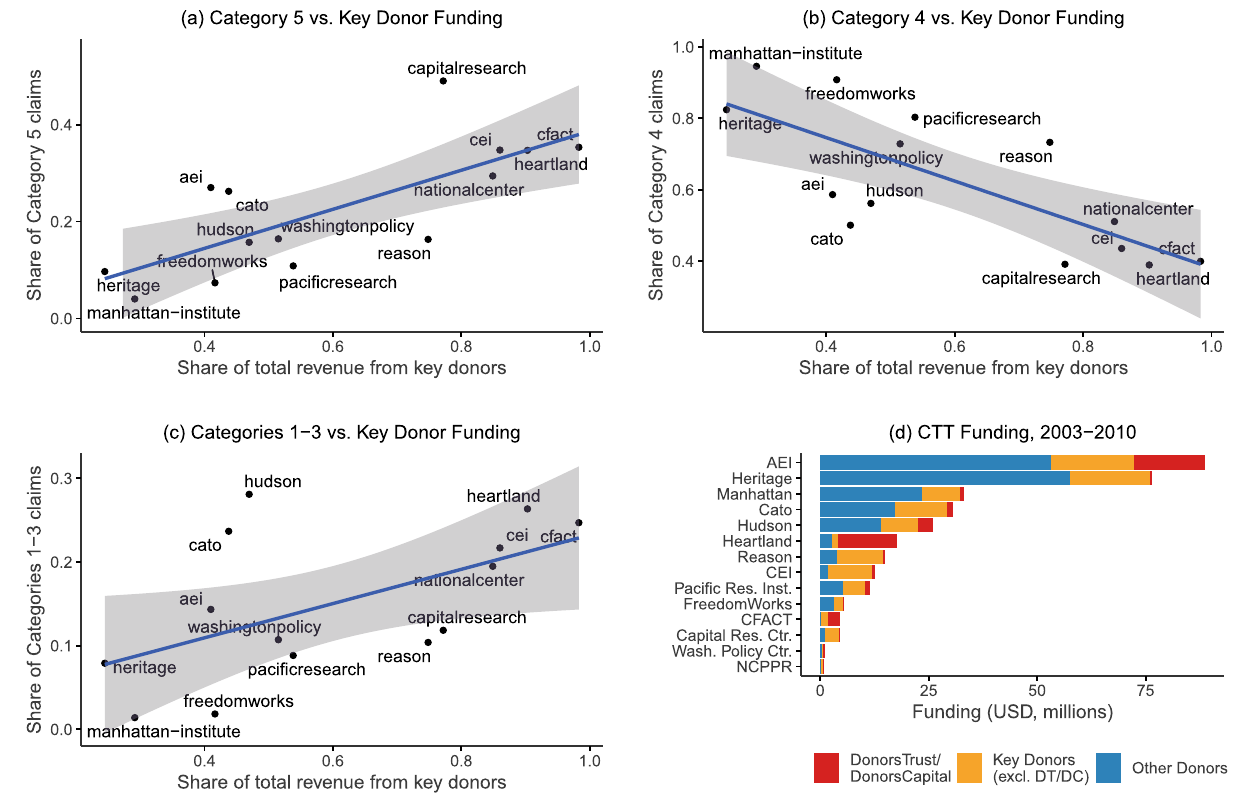
Figure 4. CTT super-claim prevalence and funding from key donors. This figure includes scatterplots and linear regression results (see Supplementary Table S6 for the full results) showing the relationship between the share of CTT funding from “key” conservative donors and the prevalence of claims from the following categories: ( a ) “Climate movement/science is unreliable” [Category 5] ( 𝛽 = 0.403 , p < 0.05 , R 2 = 0.56 ), ( b ) “Climate solutions won’t work” [Category 4] ( 𝛽 = − 0.608 , p < 0.05 , R 2 = 0.56 ), and ( c ) “Global warming is not happening”, “Human GHGs are not causing global warming” & “Climate impacts are not bad” [Categories 1–3] ( 𝛽 = 0.205 , p < 0.05 , R 2 = 0.25 ). Total funding in millions of US dollars over the period 2003-2010 is displayed in ( d ) along with the share of funding from DonorsTrust/DonorsCapital (red), key donors other than DonorsTrust/DonorsCapital (yellow), and other donors